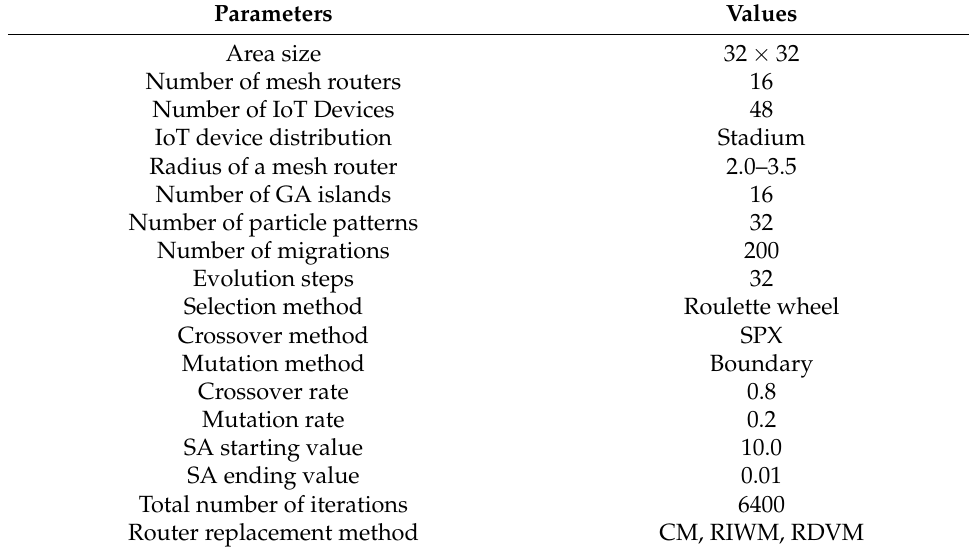
Table 2. WMN-PSOSA-DGA